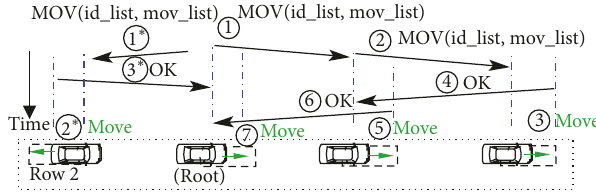
Figure 5: Communication flow for movement execution.